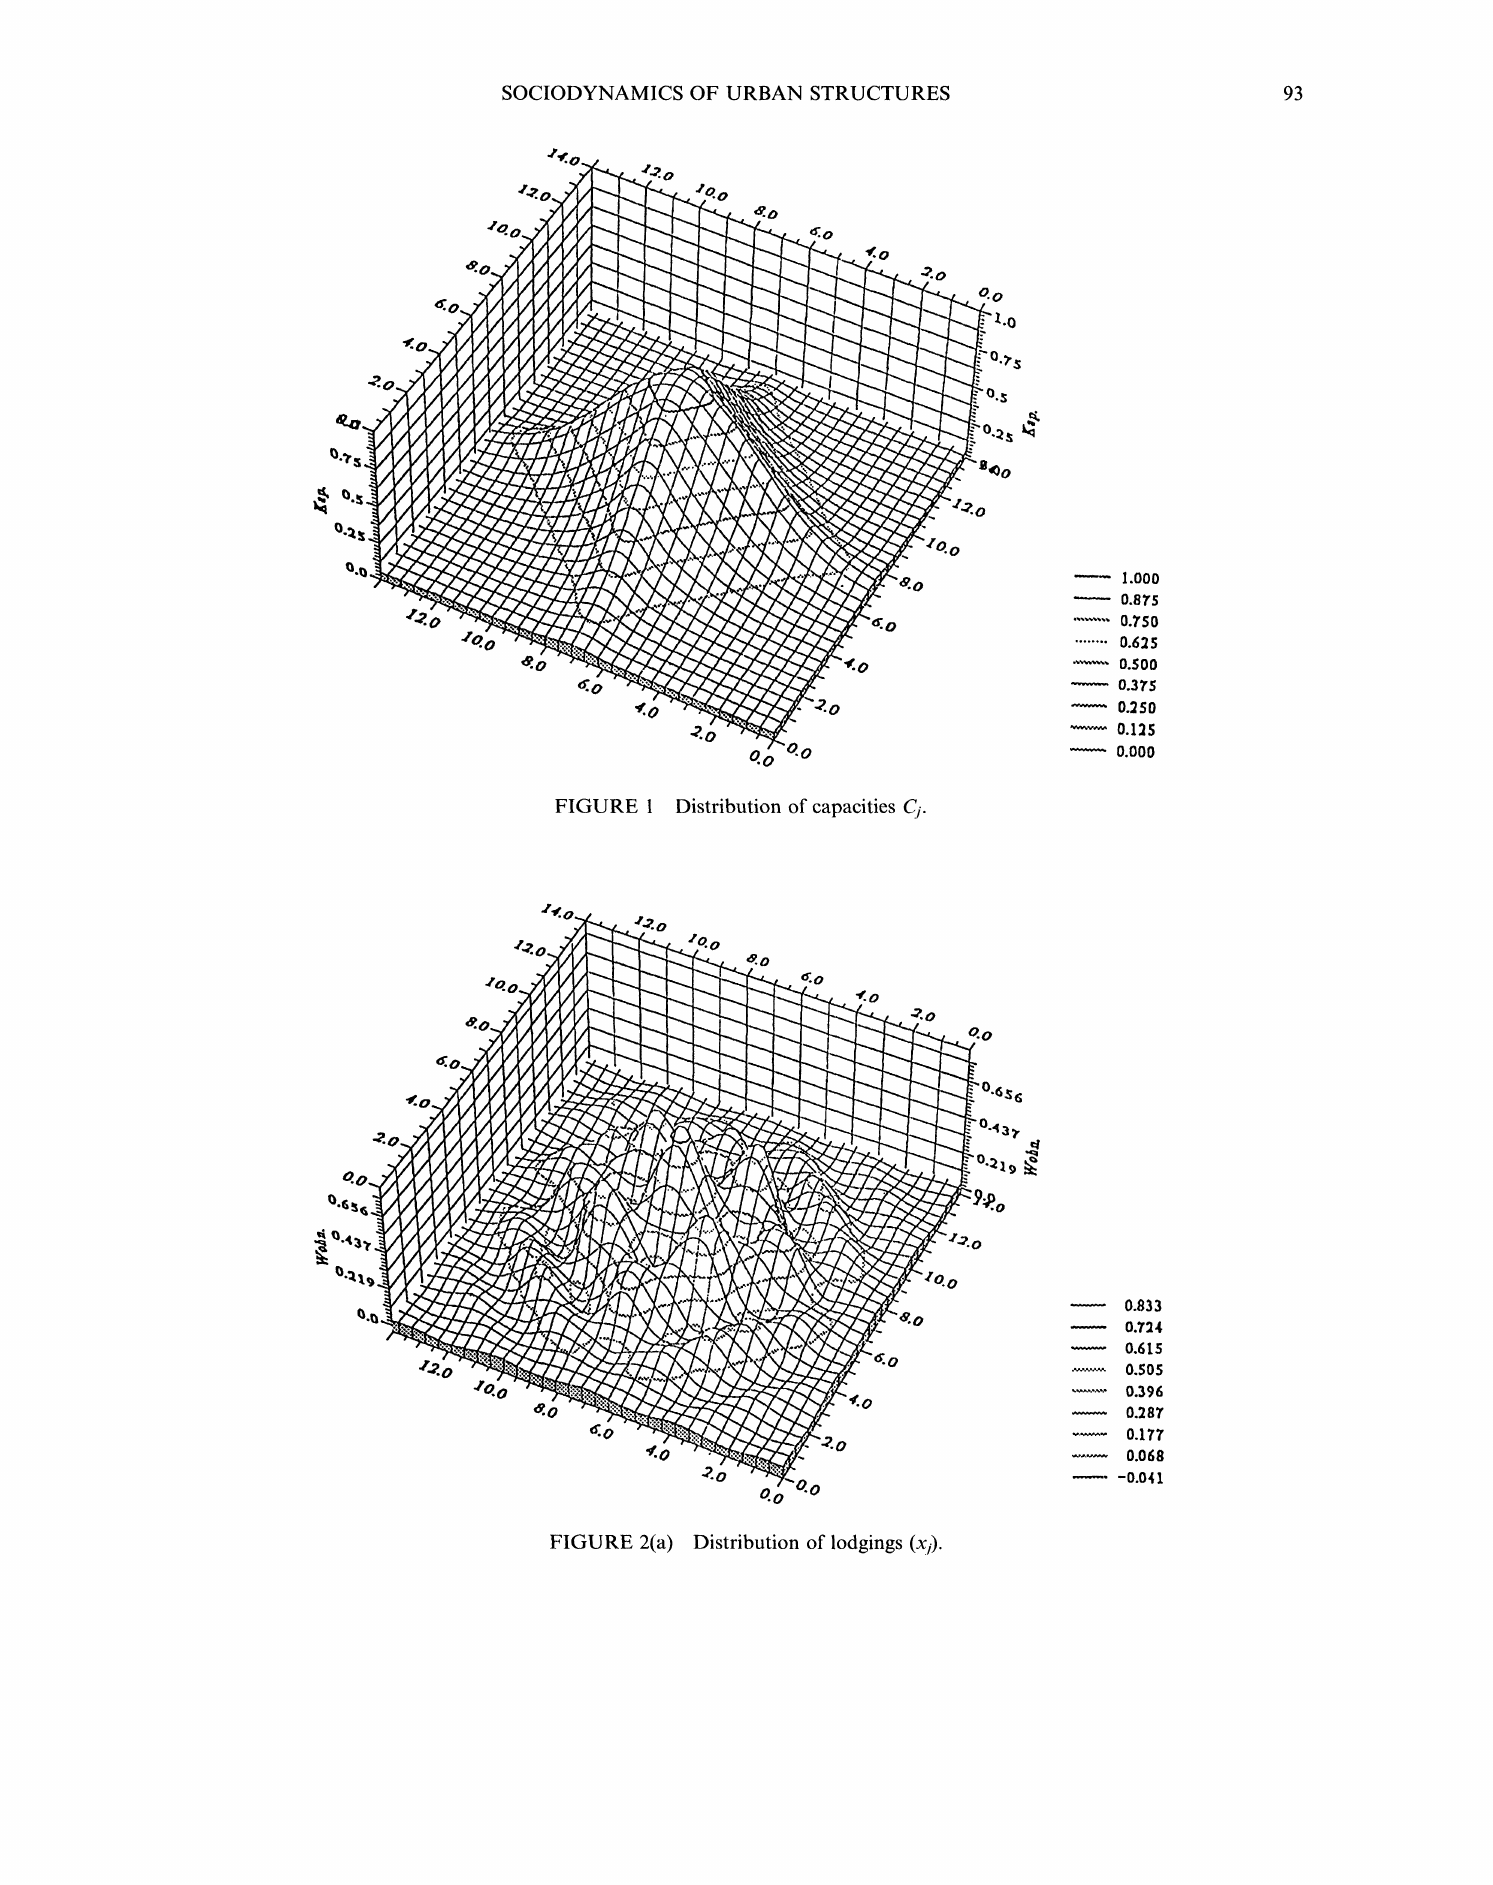
FIGURE 2(a) Distribution of lodgings (XJ).